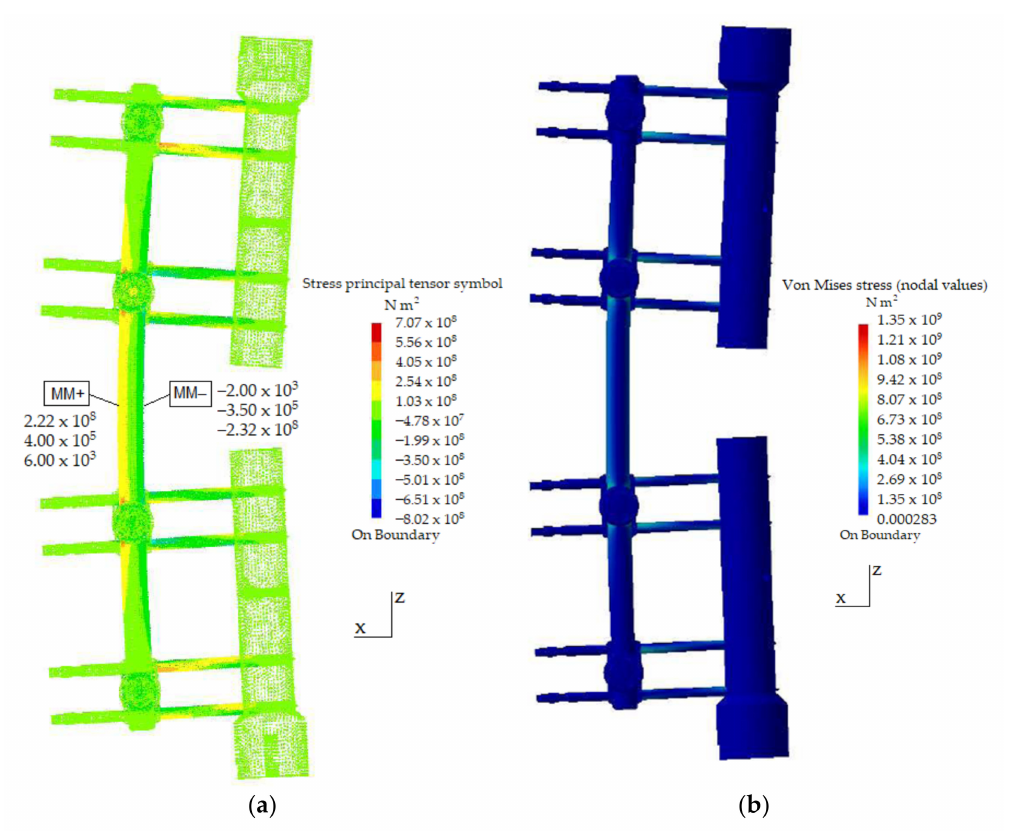
Figure 5. FEM model (B50) in structural analysis; ( a ) main stresses, ( b ) von Mises